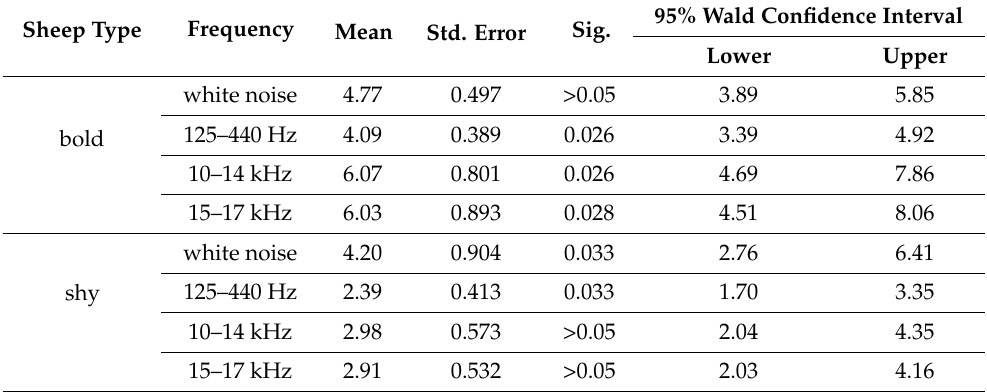
Table 8. Estimates of duration (in seconds) by the combination of sheep